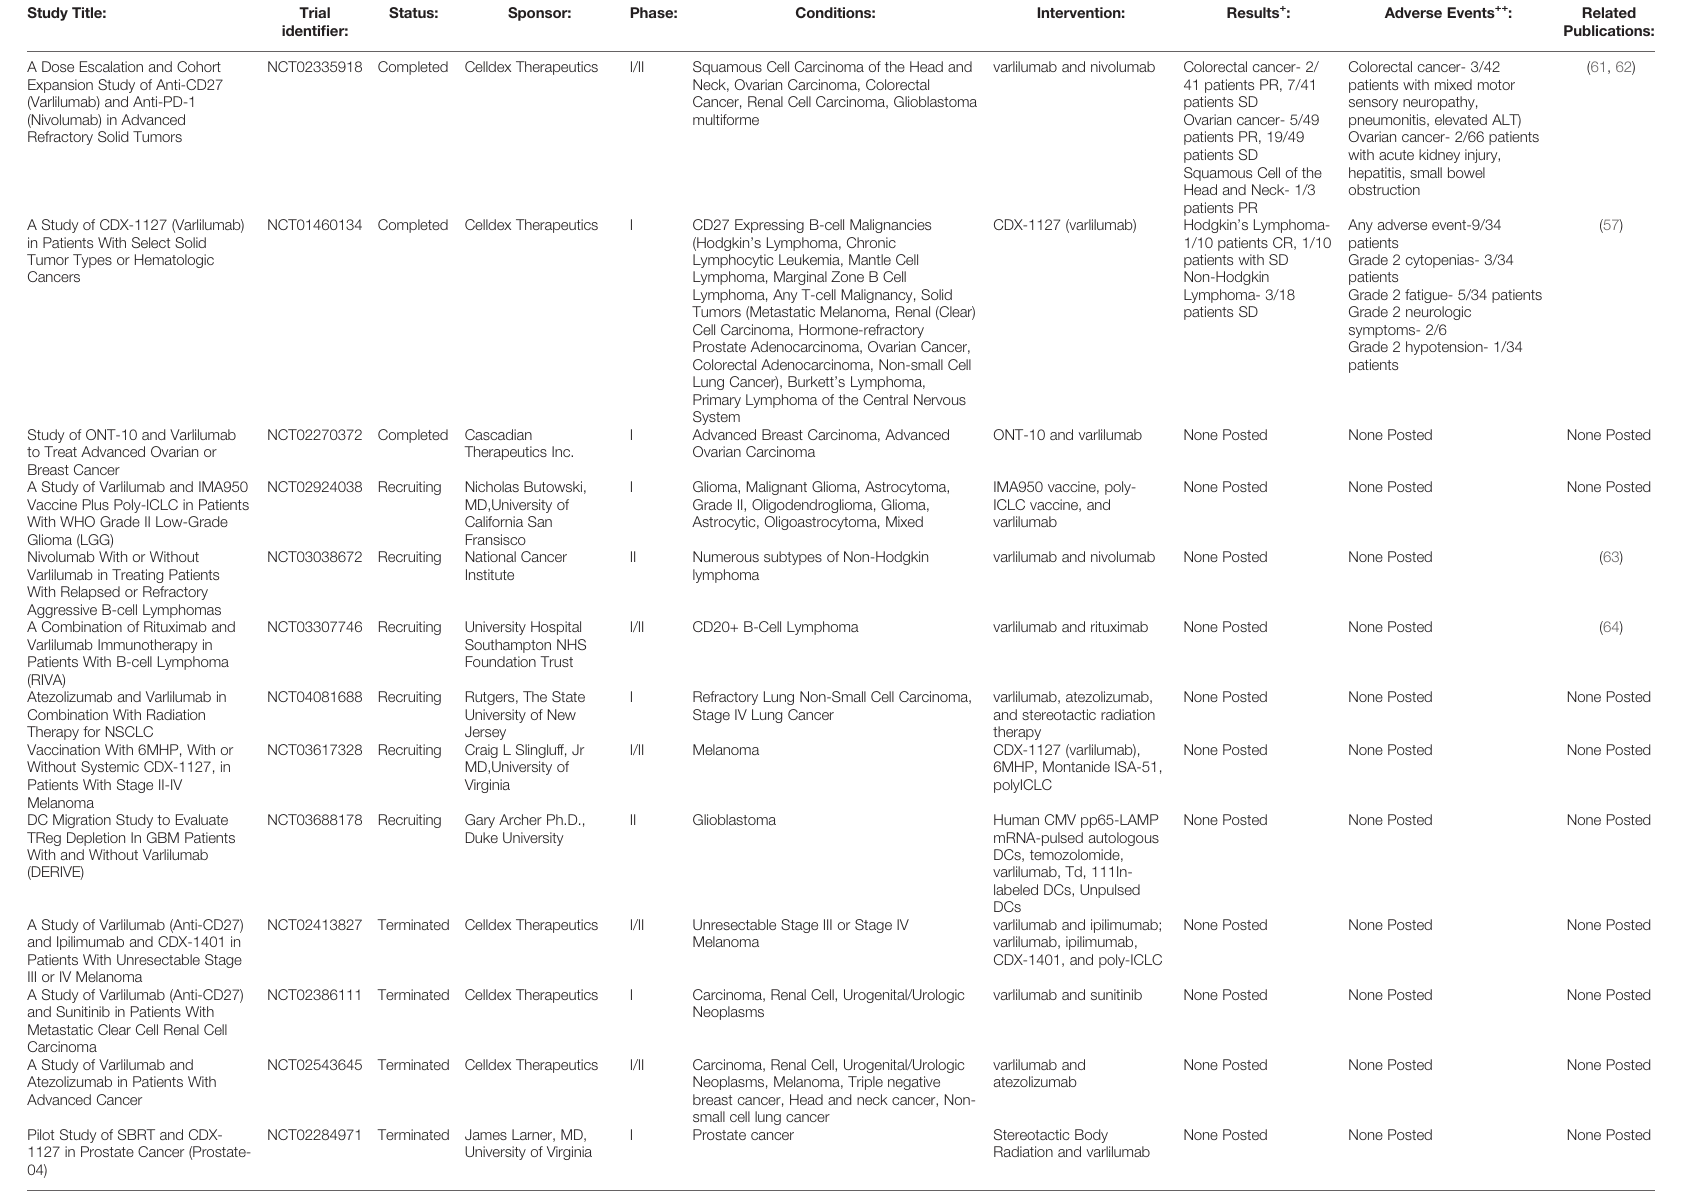
TABLE 1 | Clinical trials with CD27 agonizing monoclonal